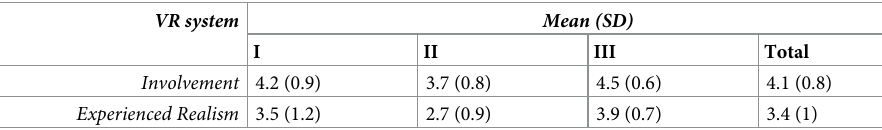
Table 10. Mean and SD of presence factors (out of